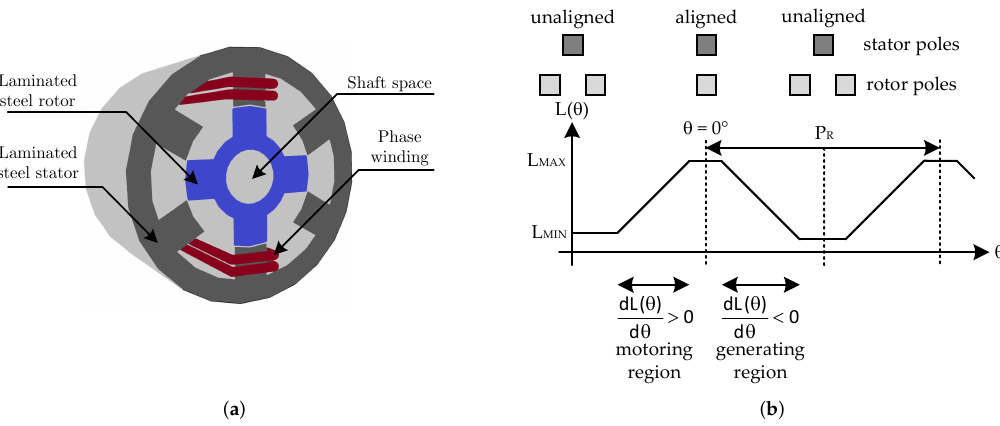
Figure 1. Cross section of a 6 × 4 SRG and its respective inductance profile as a function of the rotor angular position: ( a ) Cross section of a single-phase switched reluctance machine and ( b ) inductance profile of one of the SRG phases.